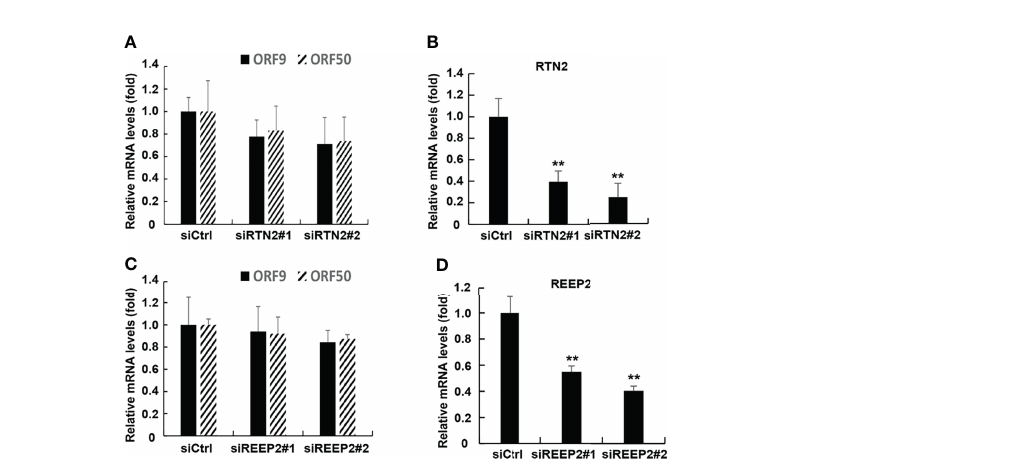
FIGURE 7 | ATL proteins have certain speci fi city in the regulation of KSHV lytic reactivation. The knockdown of RTN2 had no signi fi cant effect on the expression of KSHV lytic genes. (A) iSLK.rKSHV.219 cells were transfected with siCtrl, siRTN2 #1 , or siRTN2 #2 respectively. 48 hours later, mRNA levels of KSHV lytic genes ORF9 and ORF50 were measured by RT-qPCR, with normalization to actin using the ΔΔ CT method. (B) Knockdown ef fi ciencies of siRTN2 in iSLK.rKSHV.219 cells were measured by RT-qPCR. Data are presented as means of three technical replicates (n=3, group values are indicated by mean ± SEM; *p < 0.05; **p < 0.01).